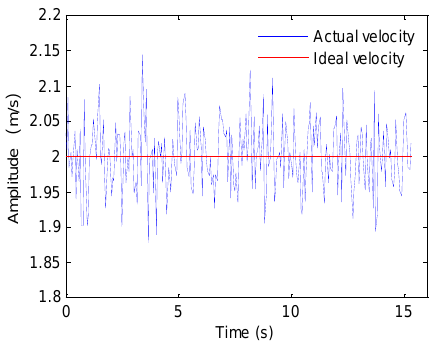
Figure 15. Platform velocity.